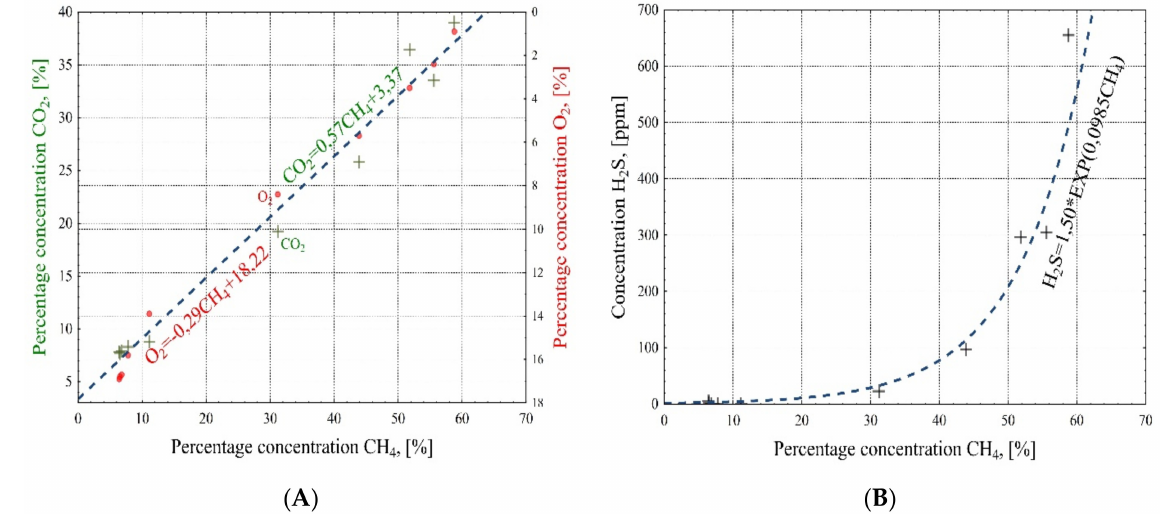
Figure 5. Correlation between the values of the indicators of percent methane (CH 4 ) concentration with percent oxygen (O 2 ) concentration (%) and percent carbon dioxide (O 2 ) concentration (%) ( A ) with hydrogen sulfide (H 2 S) concentration (ppm) ( B ).